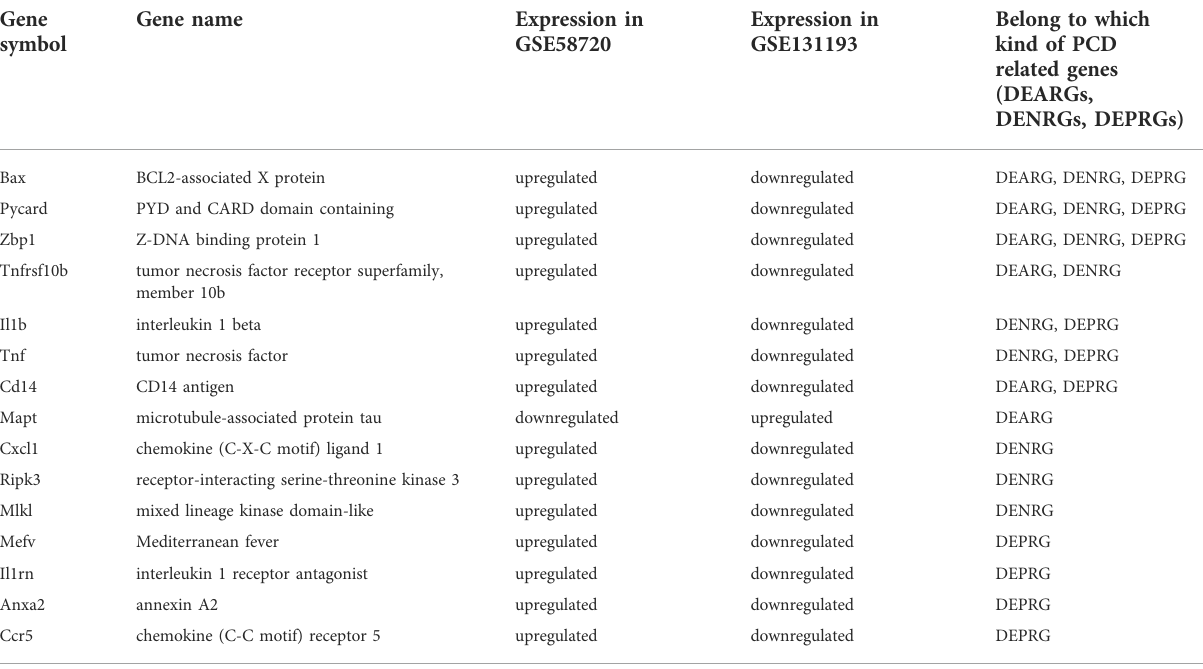
TABLE 1 Differentially expressed PCD-related